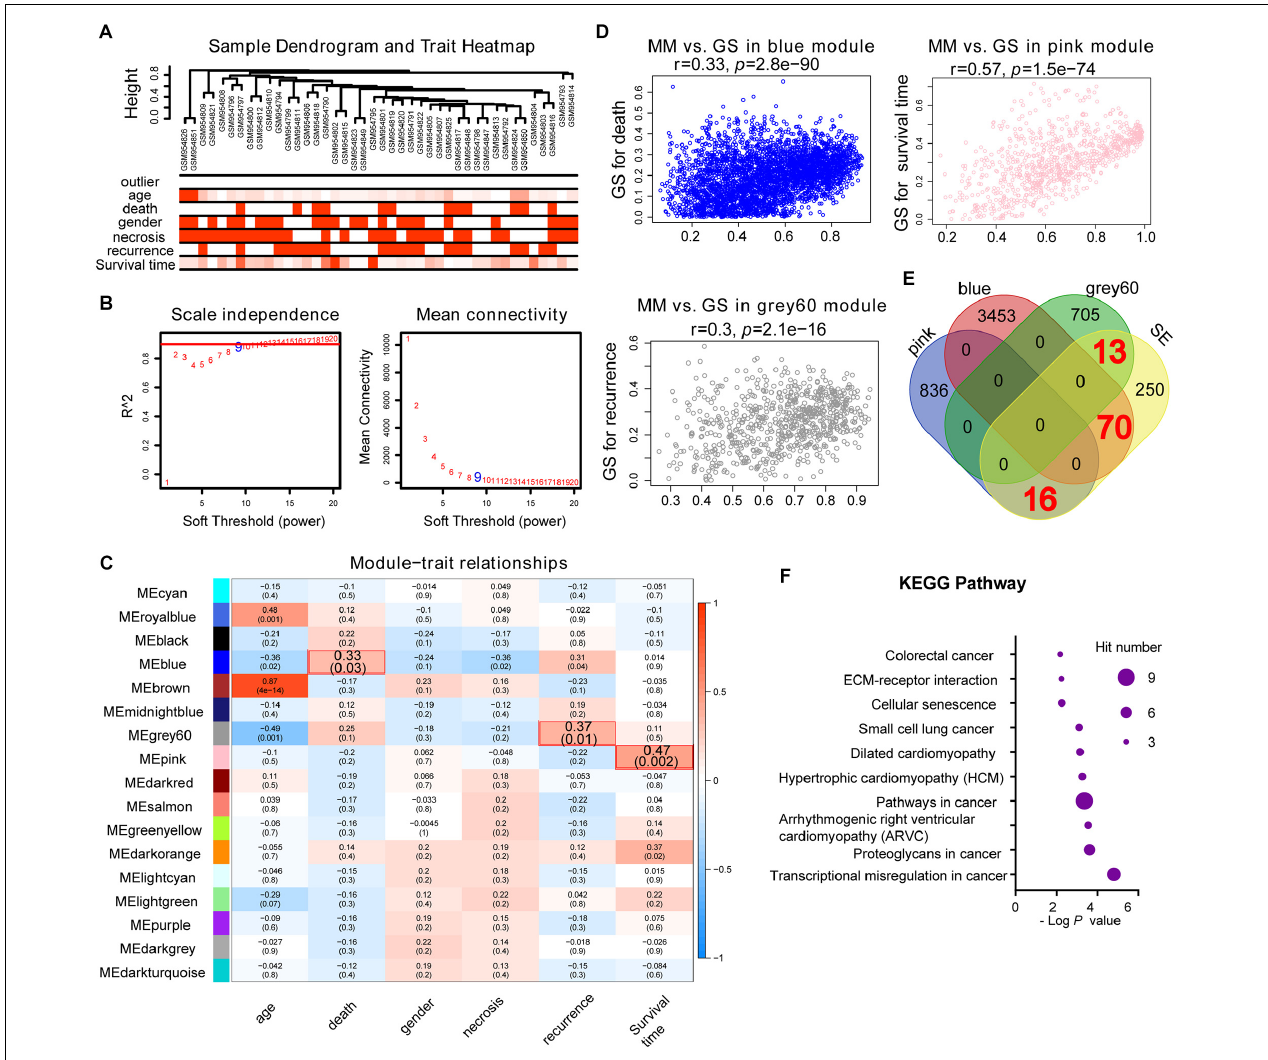
FIGURE 6 | Identification of SE-related hub genes in osteosarcoma based on the GSE39058 dataset through WGCNA analysis. (A) Cluster analysis between the gene expression in the GSE39058 dataset and sample outliers or clinical traits. Color intensity was proportional to sample outliers, age, gender, necrosis, recurrence, and survival time. (B) Analysis of the scale independence and mean connectivity (vertical axis) for various soft-thresholding powers ( β value of horizontal axis). (C) Heatmap of the correlation between modules and clinical traits of osteosarcoma; p -values in the table specify the correlation between modules and clinical traits. Three modules had high correlation with clinical traits: MEgray60 with recurrence ( r = 0.37, p = 0.01); MEblue with death ( r = 0.33, p = 0.03); and MEpink with survival time ( r = 0.47, p = 0.002). (D) Scatterplot showing the MM versus GS of module genes related to death in the blue module, recurrence in the gray60 module, or survival time in the pink module (horizontal axis: MM means module membership, vertical axis: GS means gene significance). (E) Venn plot of SE-related genes and eigengenes in the blue, gray60, and pink modules. There are 70, 13, and 16 correlated genes, respectively. (F) KEGG pathway analysis of the above-correlated genes in the Venn plot. KEGG, Kyoto Encyclopedia of Genes and Genomes; SE, super-enhancer; WGCNA, weighted gene co-expression network